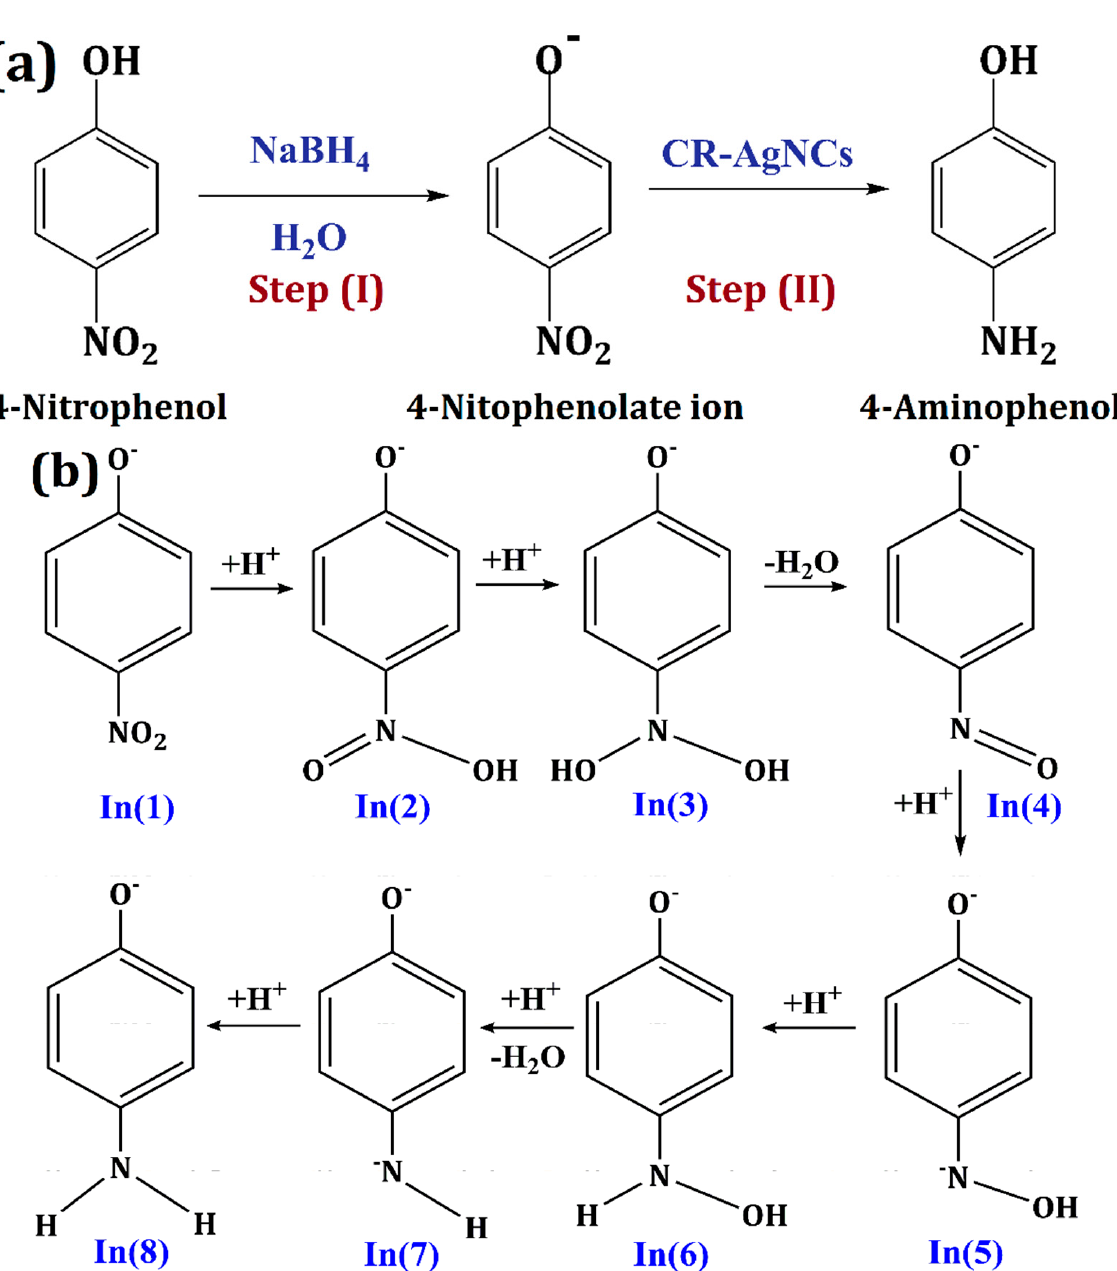
Figure 12. ( a ) Reaction steps involved in the reduction of 4-nitrophenol to 4-aminophenol; ( b ) All the possible listed formed intermediates (In 1–8).